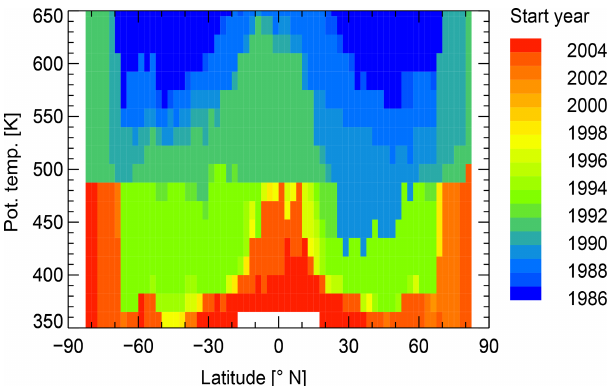
Figure A1. Distribution of start years for the “SWOOSH period” used to compare against the model results. The start time for each latitude– θ grid point is the first month for which more than 12 months of SWOOSH H 2 O data are available over the following 2years.